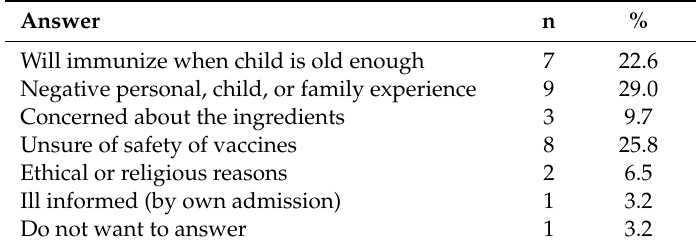
Table 3. Categorization of answers to the open ended question “Please state why you chose not to immunize” (n =